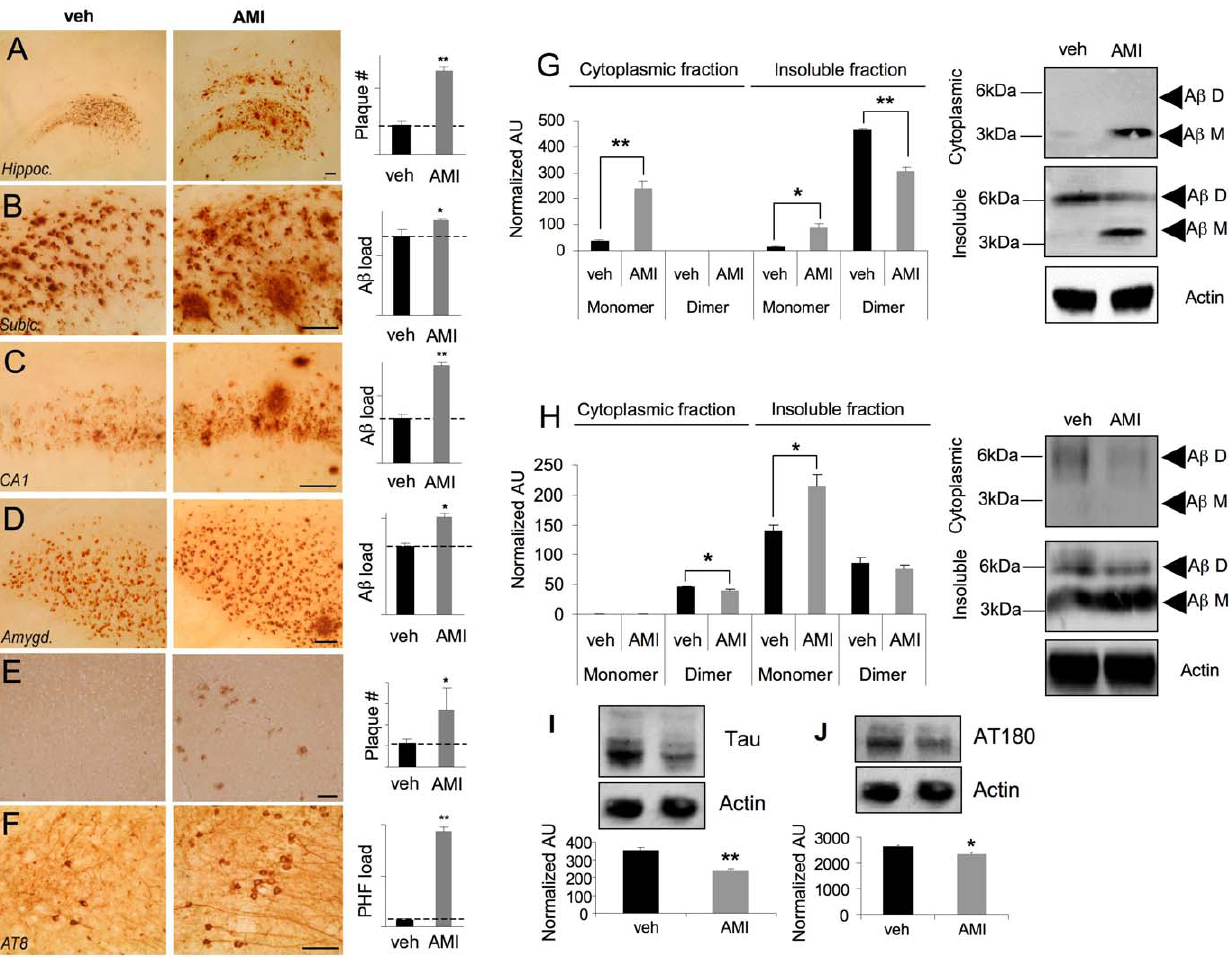
Figure 1. AMI affects A b and tau in aged 3 6 TgAD mice . Vehicle (veh)- and AMI-treated A b expression in 3 6 TgAD hippocampus (A), frontal cortex subiculum (B), CA1 region (C), and amygdala (D). (E) AMI/veh effects on A b load in the frontal cortex. (F) AMI/veh effects on hippocampal PHF load. Histograms depict relative quantification of associated panels (A–F). AMI effects on hippocampal (G) or cortical (H) A b disposition. (I) AMI/veh effects upon total soluble hippocampal tau levels. (J) AMI/veh effects upon soluble phosphorylated PHF tau. For this and subsequent analyses, values in histograms represent mean 6 SEM (n=6), * p , 0.05, ** p , 0.01, *** p , 0.001. doi:10.1371/journal.pone.0021660.g001 PLoS ONE |